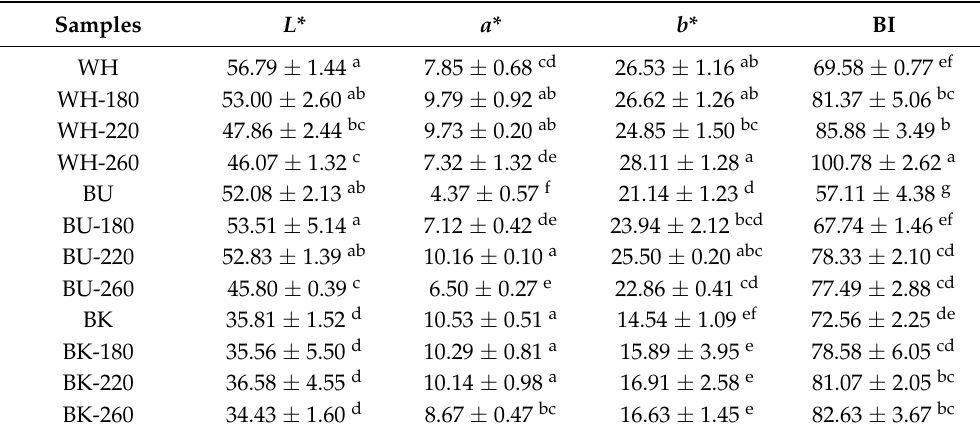
Table 1. The color parameters of CHB roasted at different temperatures.